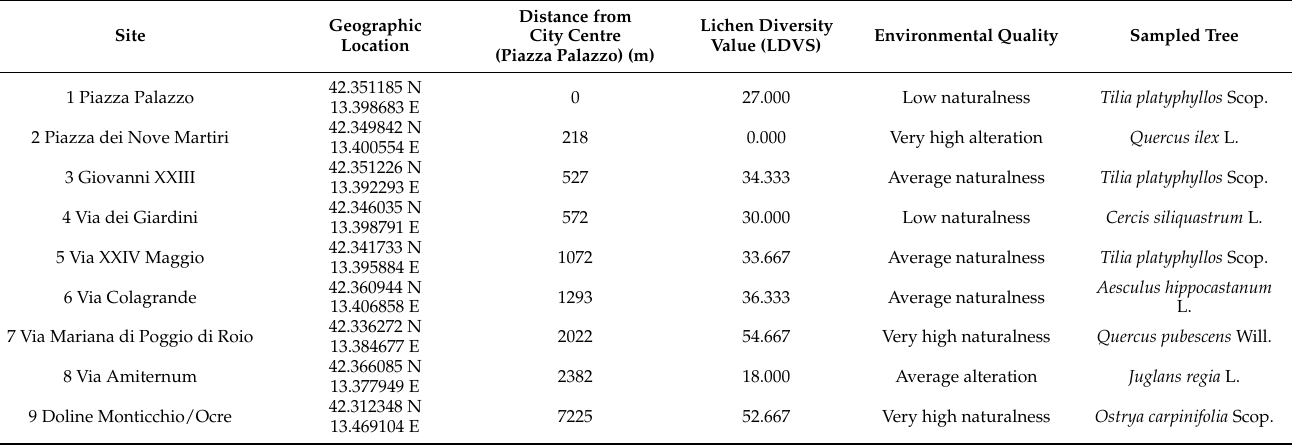
Table 1. Geographic location, distance from city centre, Lichen Diversity Value and environmen- tal quality of the nine sites investigated along the urban–rural gradient in the city of L’Aquila (Central